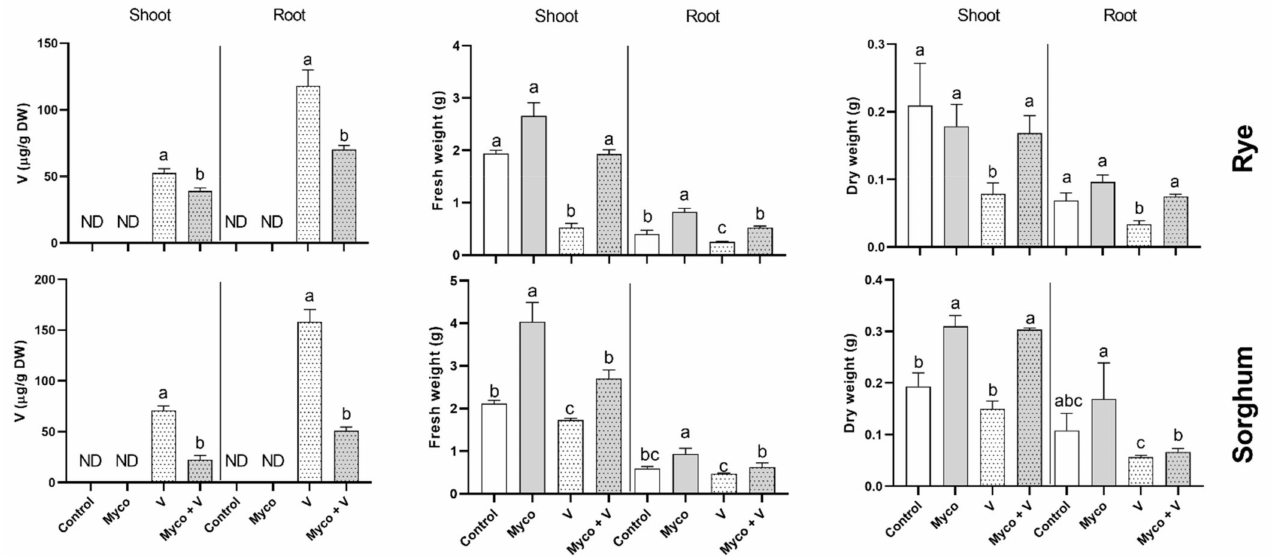
Figure 1. Accumulation of vanadium and changes in fresh and dry weights of shoots and roots in six-week-old rye and sorghum grown in soils with 0 or 350 mg/kg soil sodium vanadate and with or without soil enrichment with inoculum of the mycorrhiza Rhizophagus irregularis . Data are mean values ± SE ( n = 3). Data were statistically analyzed by one-way ANOVA followed by Tukey’s posthoc test for comparing the means. Different letters indicate a statistically significant difference between means of the same plant species at a significance level of at least ( p ≤